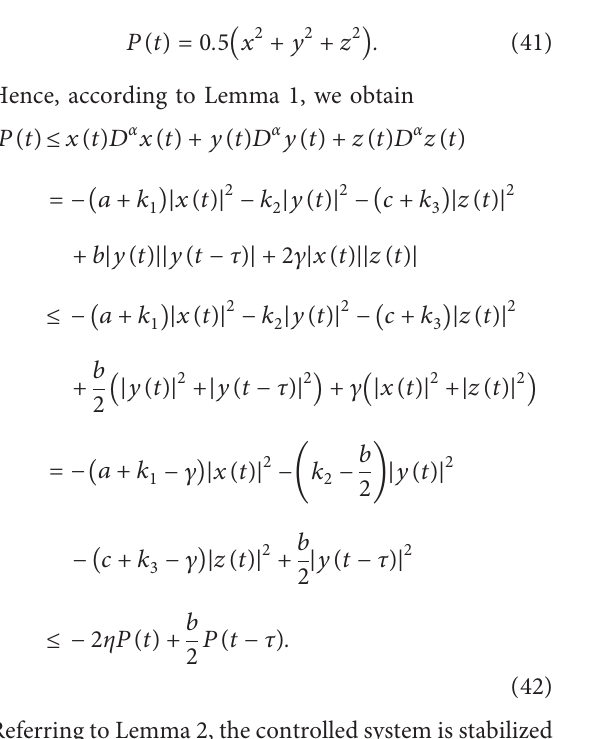
� 1 , k � 2 , and k � 1 2 3